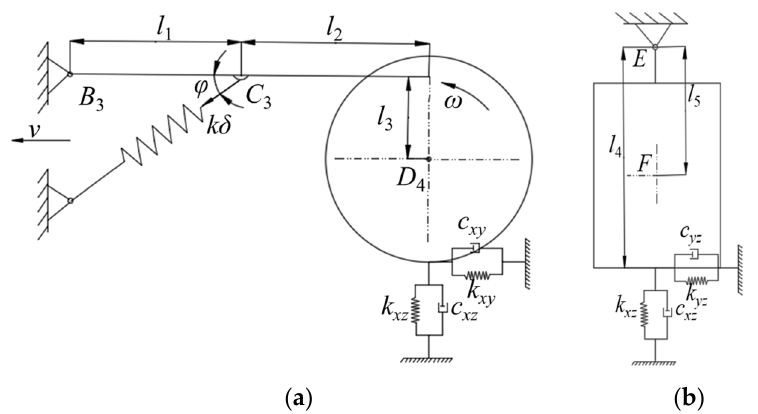
Figure 4. A 2-DOF mathematical model: ( a ) longitudinal rotation;( b ) lateral